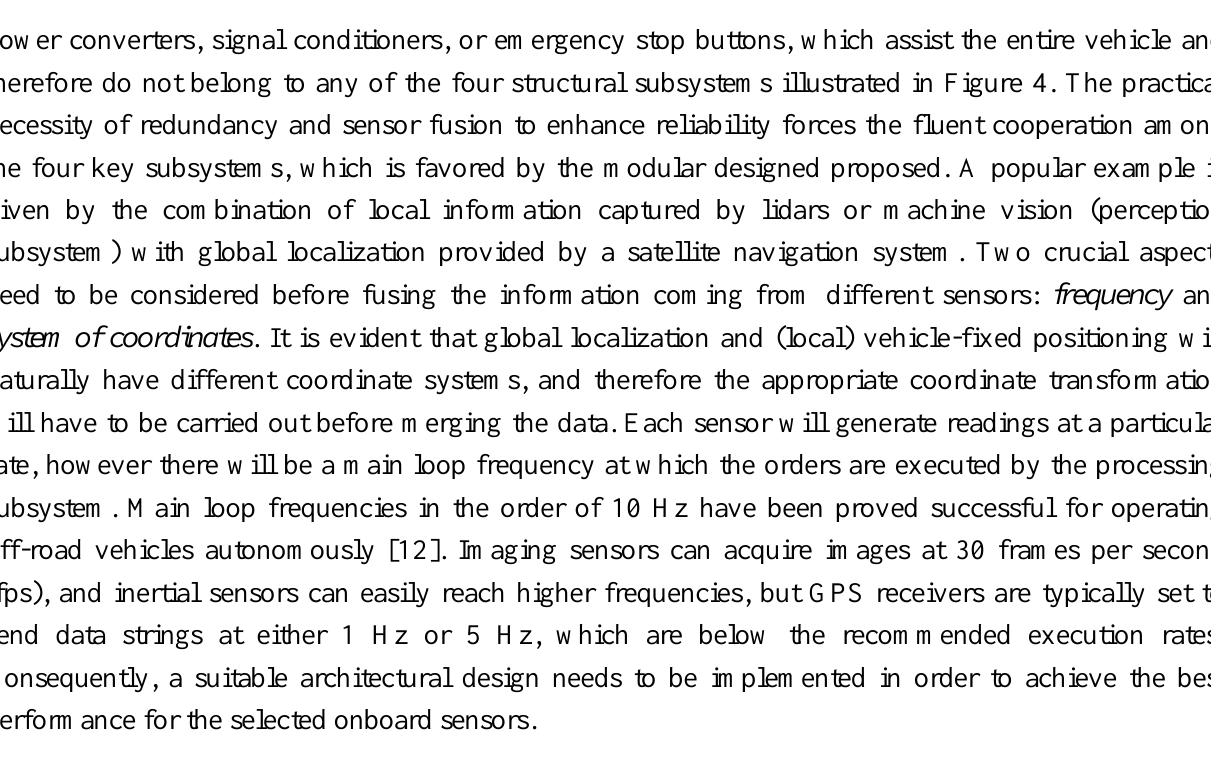
Figure 4. Four-core subsystem architecture for intelligent agricultural